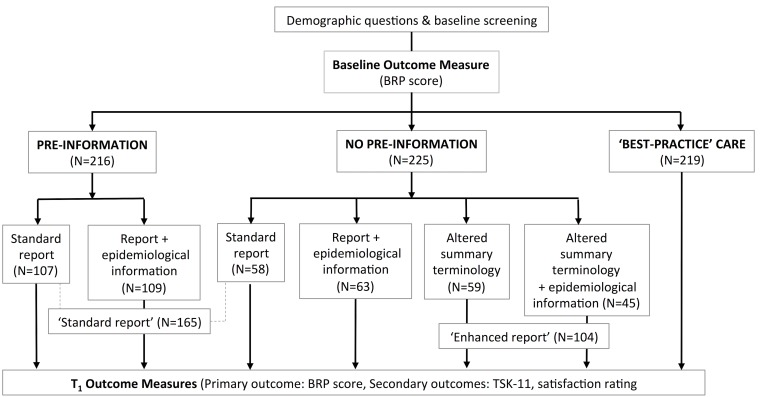
Online study set-up.